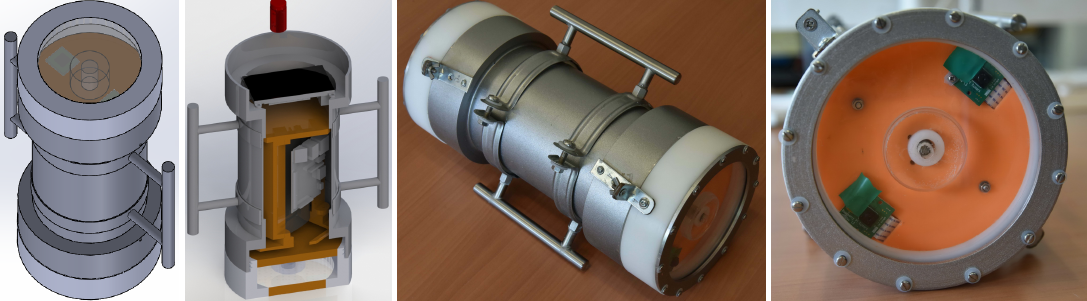
Figure 1. The handheld stereo system design and prototype.